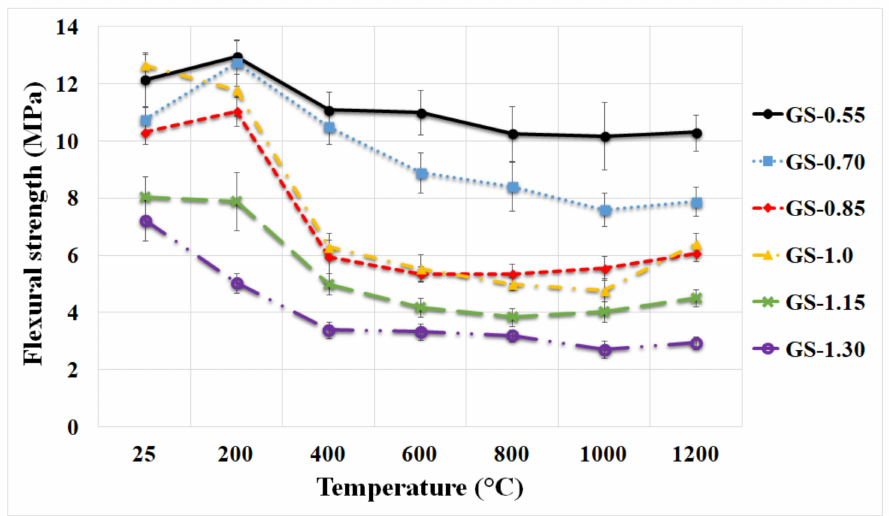
Figure 6. Flexural strength of the geopolymer composites with various molar ratios of K/Al at laboratory temperature and after exposure up to 1200 ◦